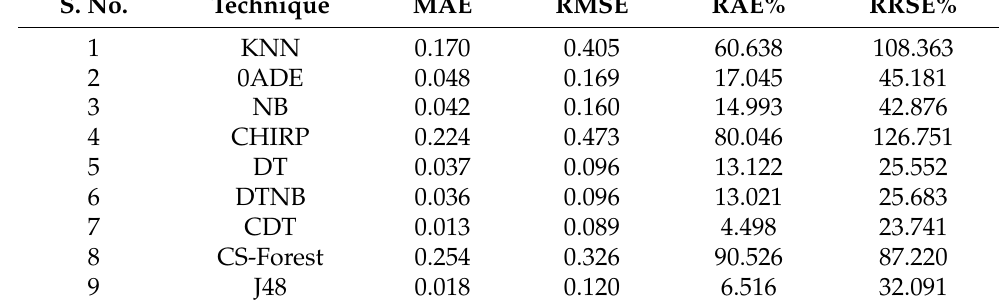
Table 25. Error Rates analysis of each employed technique. S. No.